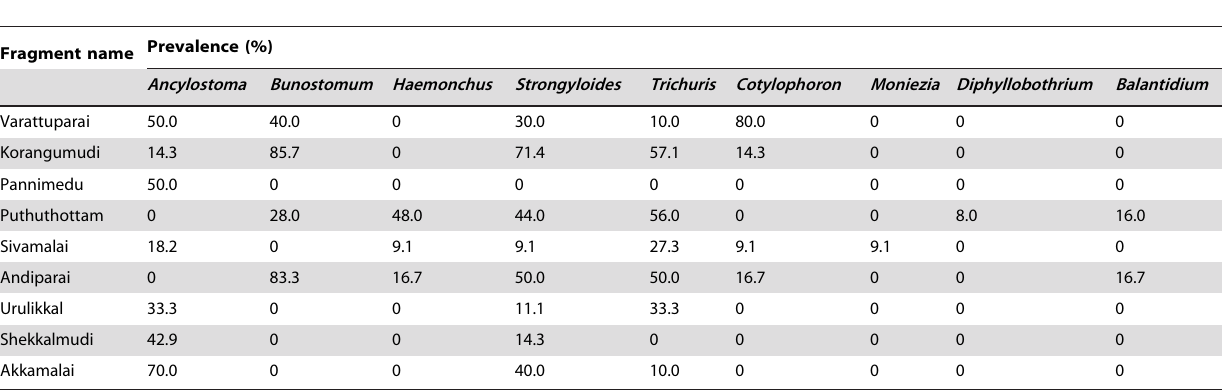
Table 2. The prevalence of different taxa of gastrointestinal parasites in lion-tailed macaques in the nine rainforest fragments.